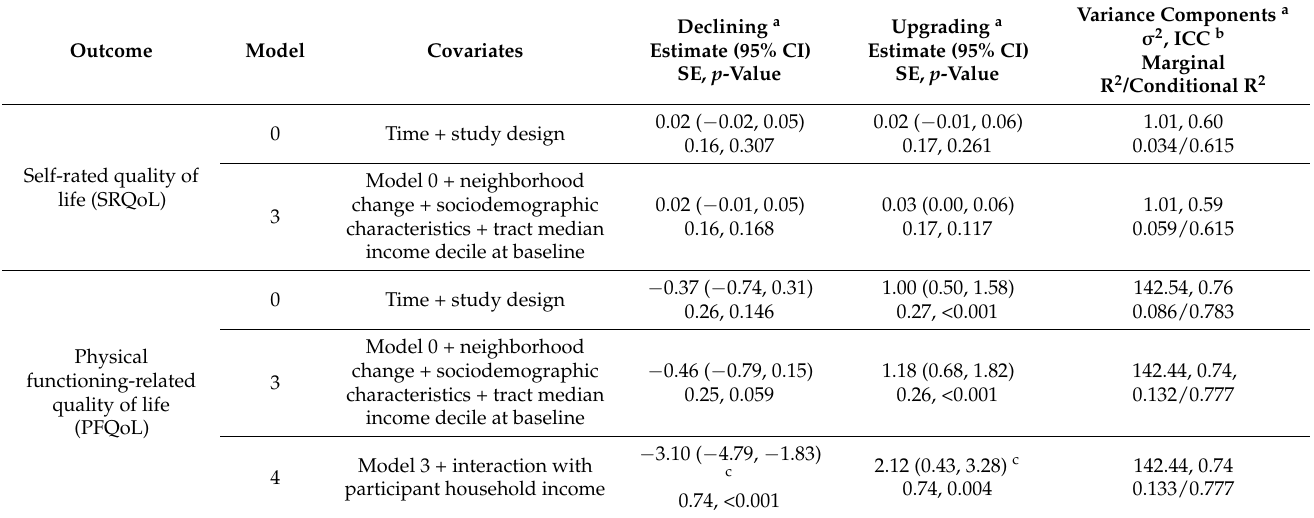
Table 3. Point Estimates and 95% Confidence Intervals for Quality-of-Life Outcomes and Change Relative to Stable Neighborhoods for Unadjusted and Fully-Adjusted